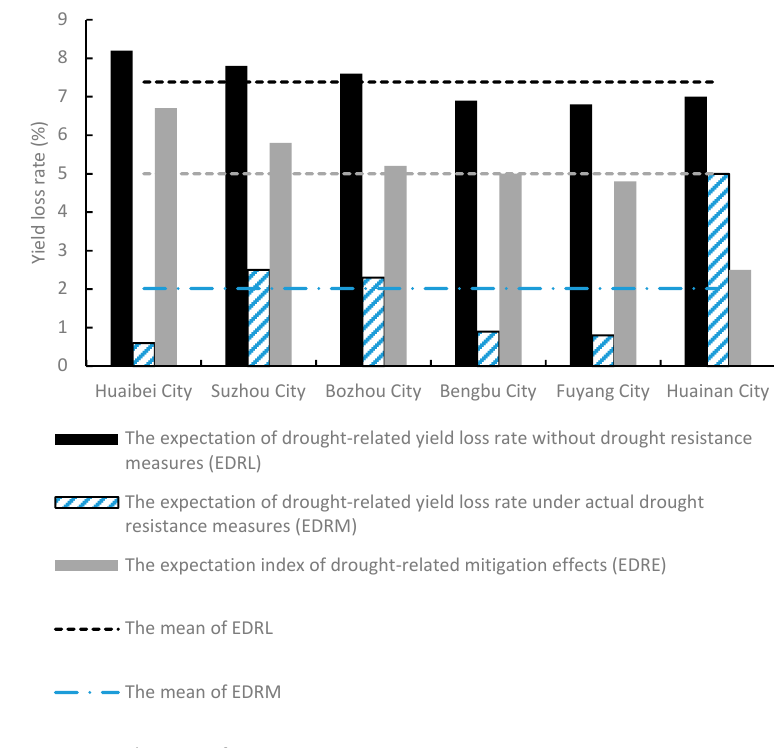
Figure 5. The expectation of drought-related yield loss rate without drought mitigation measures and under actual drought mitigation measures (EDRL and EDRM, respectively) and the drought mitigation effects expectation index (EDRE) in the study site.